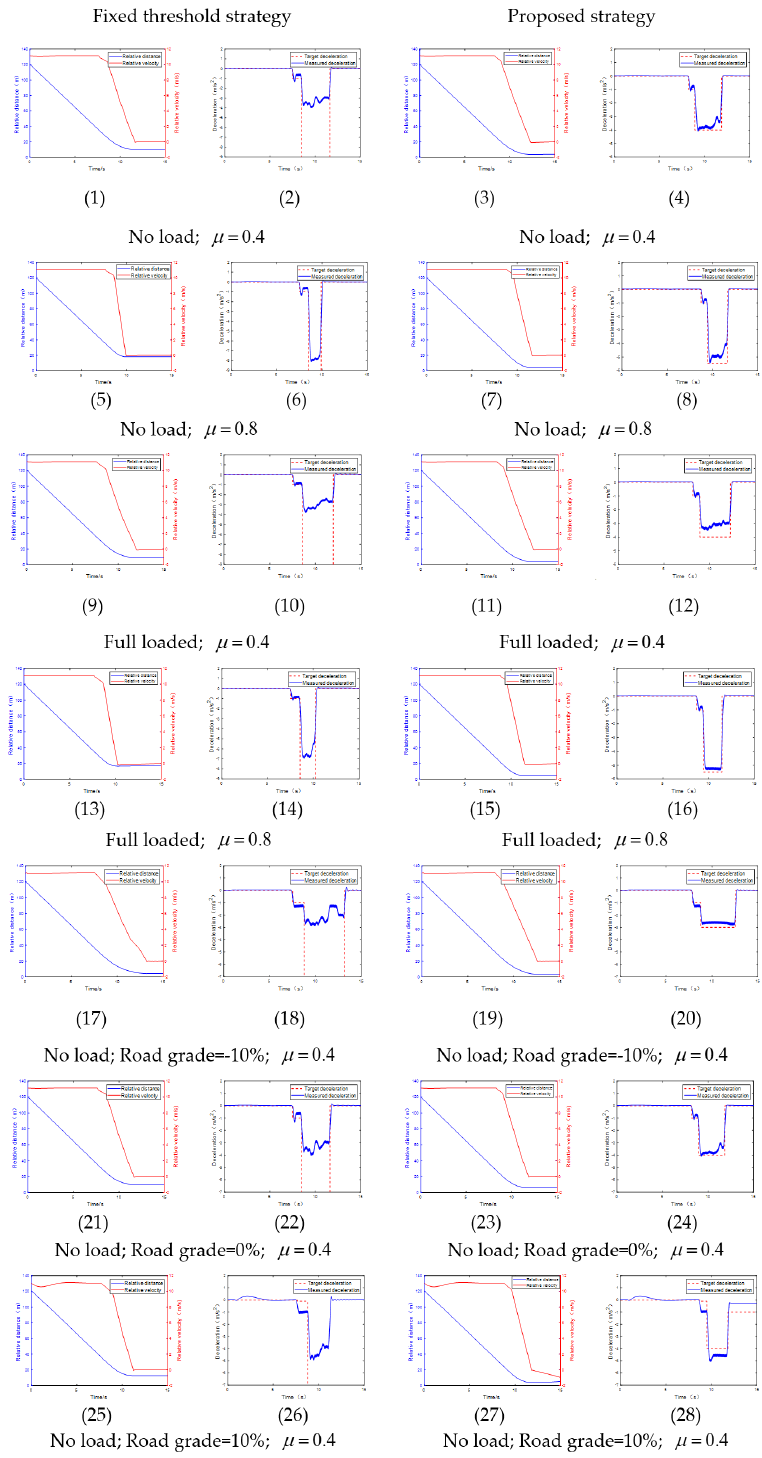
Figure 19. Comparison of experimental results for the CCRs scenario. 4.2. CCRm Scenario The initial speed of the host vehicle was 80 km/h, the speed of the target vehicle was 12 km/h, the initial distance was 120 m, and the road grade was 0%. The test results are shown in Figure 20.